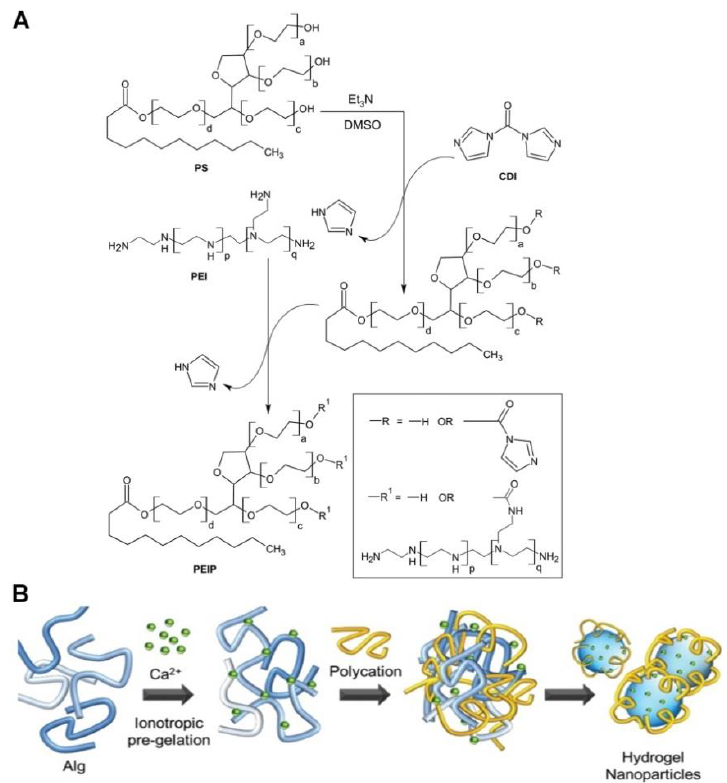
Figure 6. ( A ) Schematic illustration for the synthesis of polyethylenimine- graft -PS (PEIP) copolymer. ( B ) Schematic representation for the fabrication of hydrogel NPs using PEIP and alginate (TEA: triethylamine, DMSO: dimethyl sulfoxide, CDI: carbonyldiimidazole). Reproduced with permission from Reference [112]. Copyright 2016, Royal Society of Chemistry.